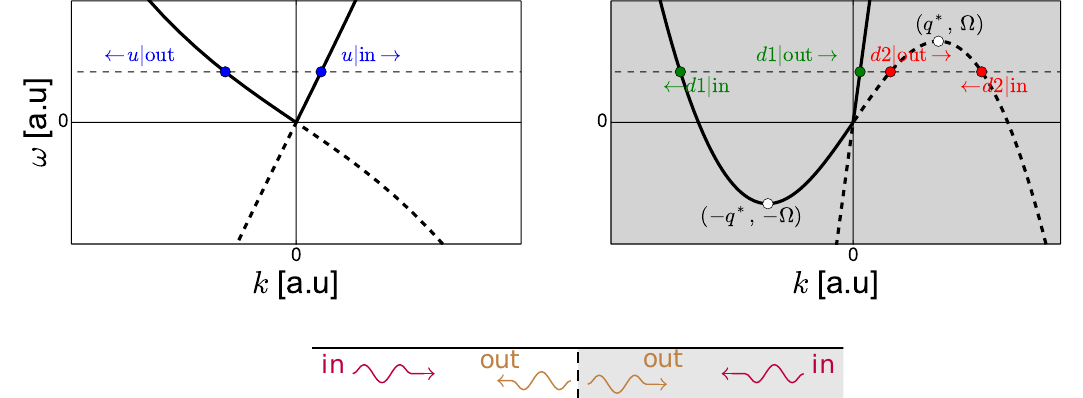
Figure 2: Dispersion relations. The left plot corresponds to a subsonic flow. The right plot corresponds to a supersonic flow; it is shaded in order to recall that it describes the situation inside the black hole. In each plot the horizontal dashed line is fixed by the chosen value of ω . The q (cid:96) ( ω ) ’s are the corresponding abscissas, with (cid:96) ∈ { u | in, u | out } in the left plot and (cid:96) ∈ { d 1 | in, d 1 | out, d 2 | in, d 2 | out } in the right plot. The direction of propagation (left or right) of the eigen-modes is represented by an arrow. The lower diagram illustrates schematically the “ingoing” and “outgoing” terminology used in the text and in the two upper